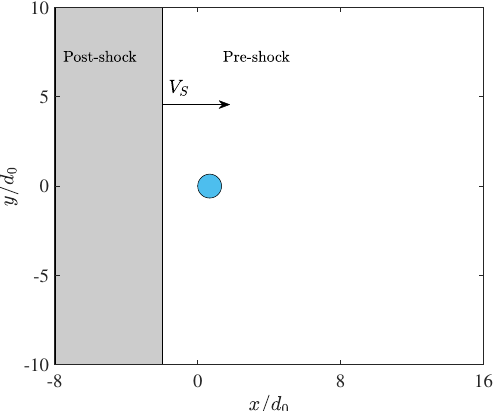
Figure 1. Sketch of the physical model with traveling shock wave. The shock tube was divided into two parts by means of a virtual cross diaphragm, which was initially located at x / d 0 = 2 (upstream of the column). In the following, the − gas conditions at the right and left sides of the tube are indicated by the subscripts 1 and 4, respectively. The two tube sections were initialized with the same temperature ( T 4 / T 1 = 1) and very different pressure and density levels ( p 4 / p 1 = ρ 4 / ρ 1 1), with the ideal gas (cid:29) air being at rest on either side ( V 4 = V 1 = 0). Starting from these initial conditions, a planar shock wave develops and travels towards the right side (driven section), while a set of expansion waves propagate towards the left one (driver section). The